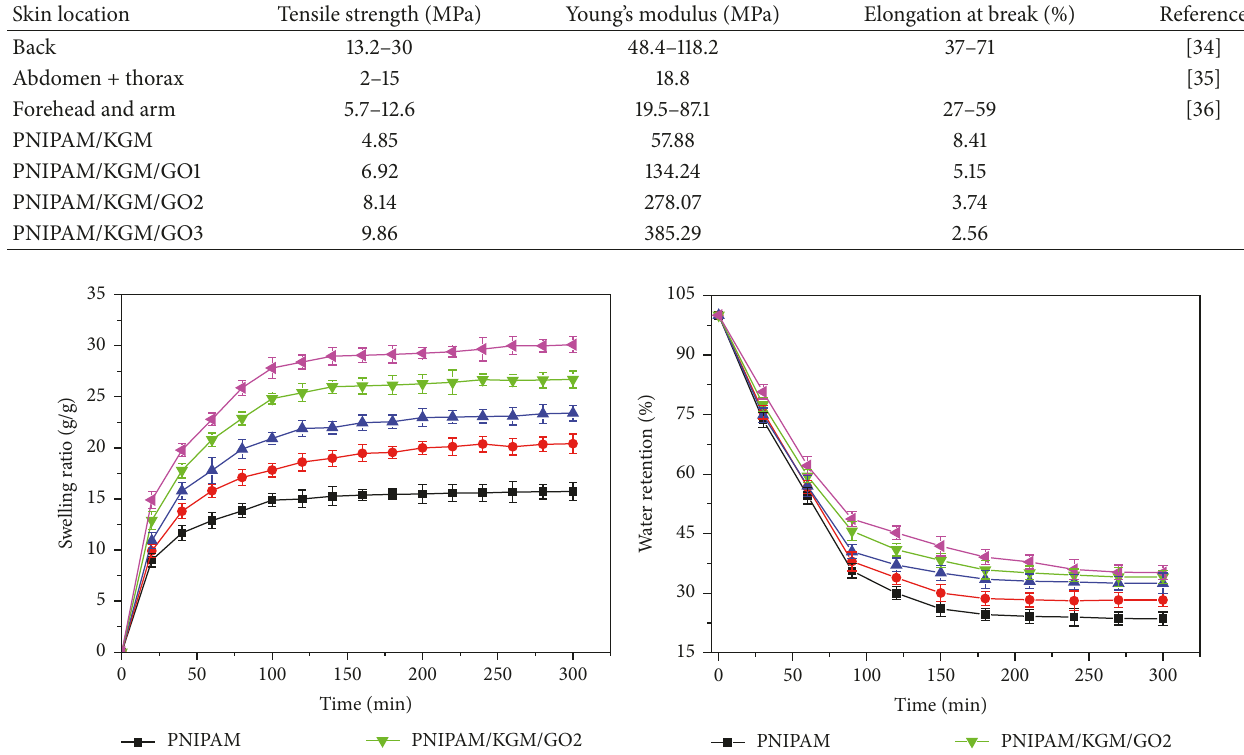
Table 2: Comparison of mechanical properties of PNIPAM/KGM/GO composite membranes to those of human skin.